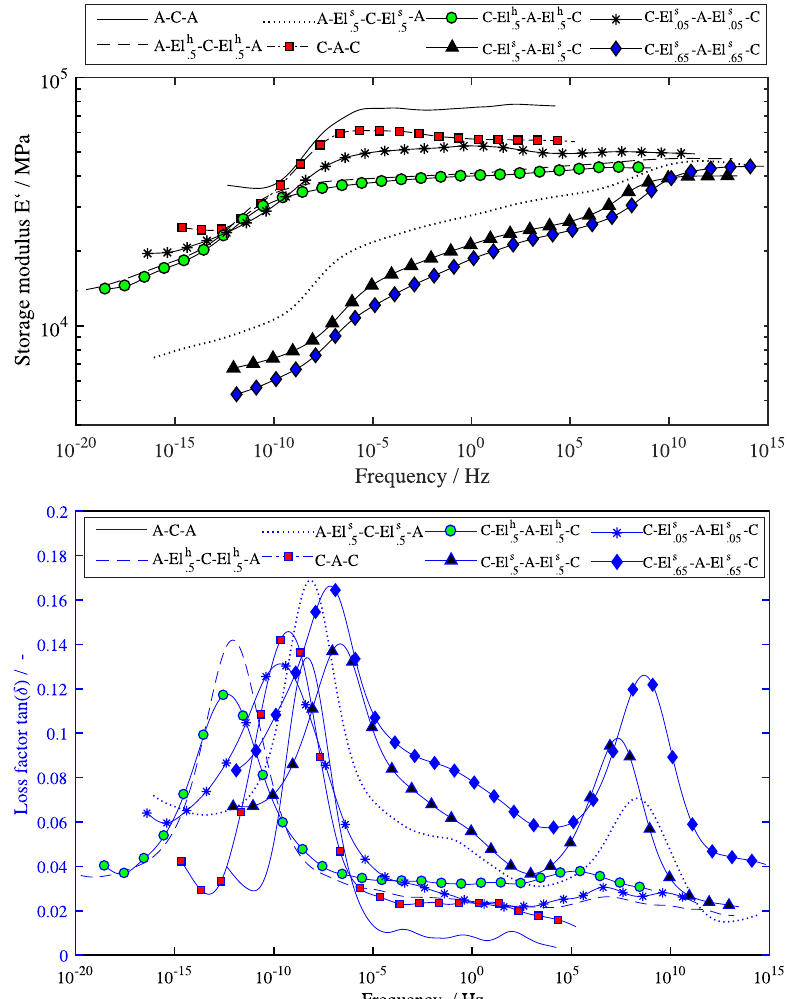
Figure 9. Master curves for all specimens. For better visibility, fewer markers are displayed for the fitted